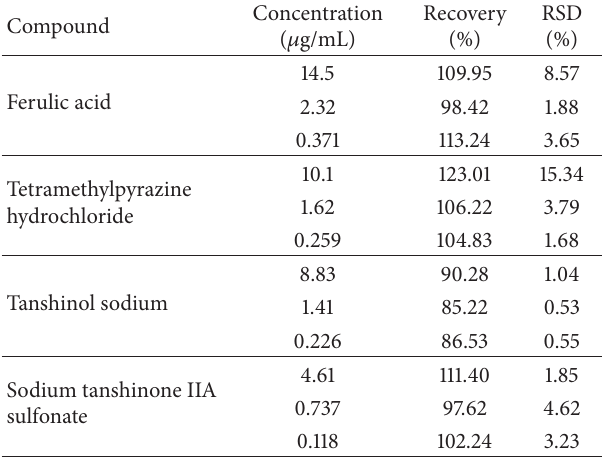
Table 4: The extraction recovery of 4 compounds in rat plasma (𝑛 = 5)